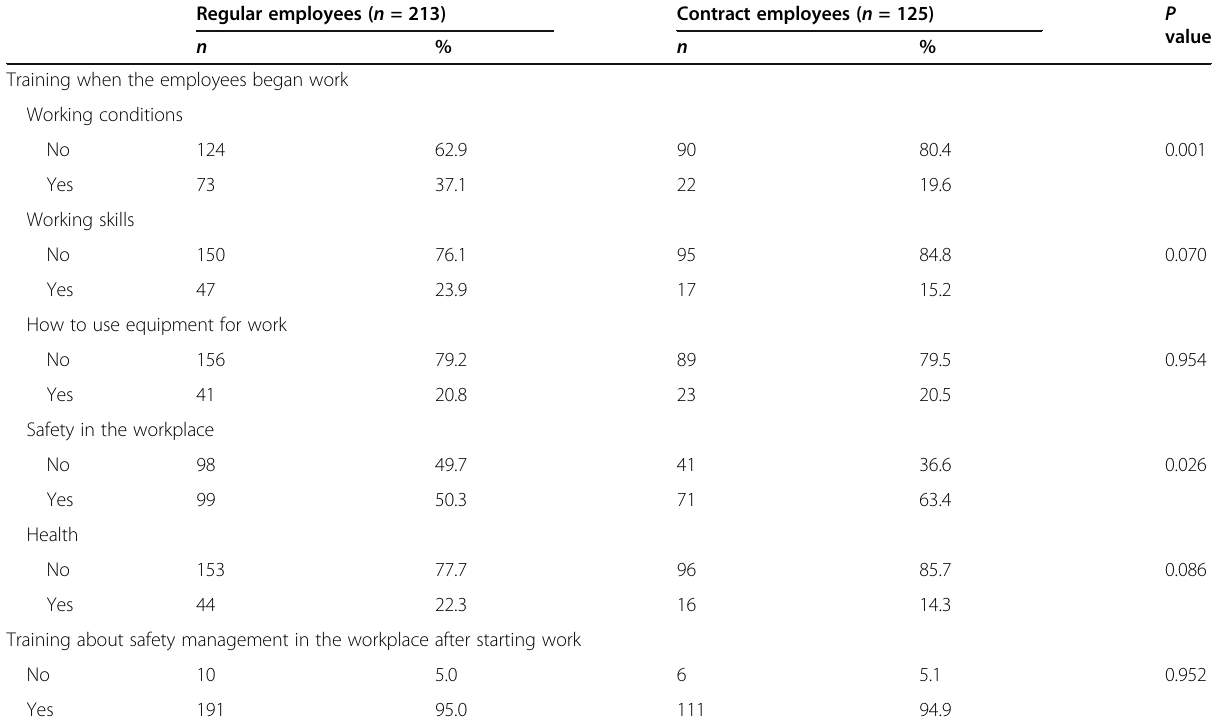
Table 4 Training opportunities ( n = 338) Regular employees ( n =